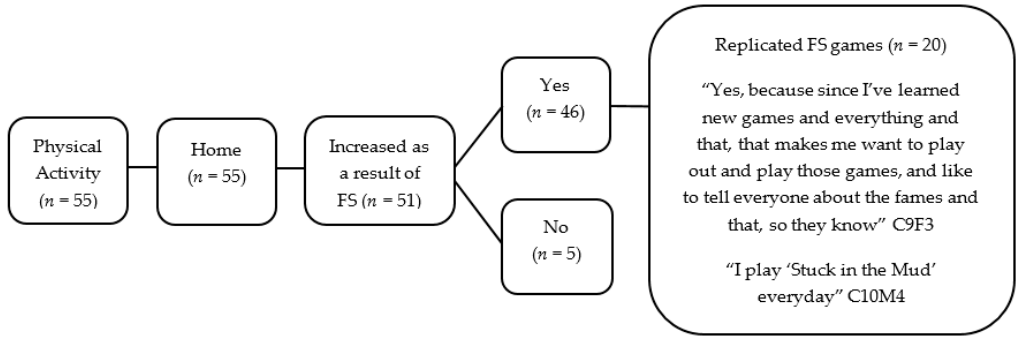
Figure 6. Pen profile demonstrating PA influenced by FS sessions.